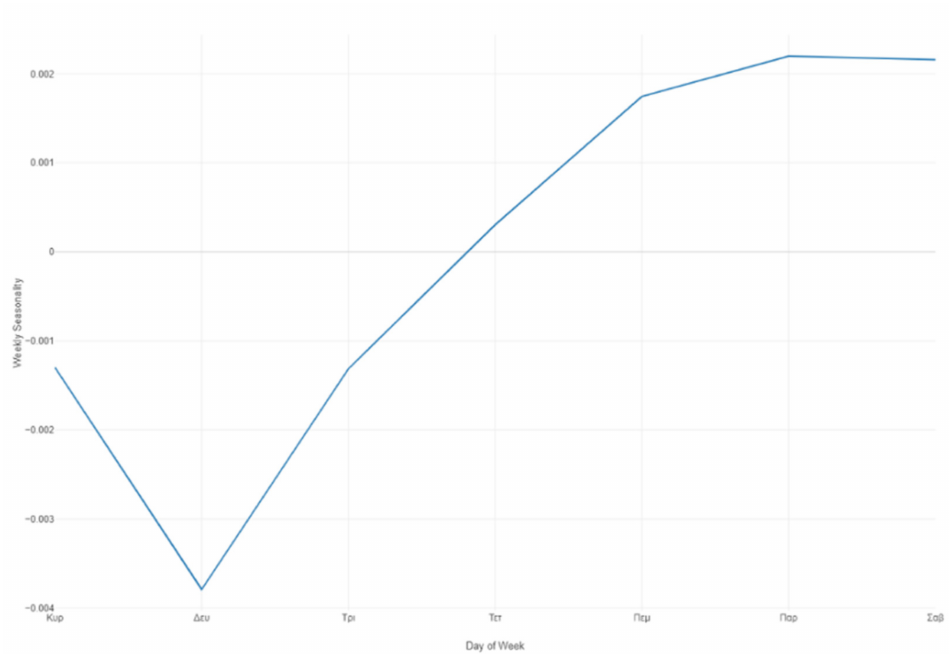
Figure 35. Prophet forecast weekly